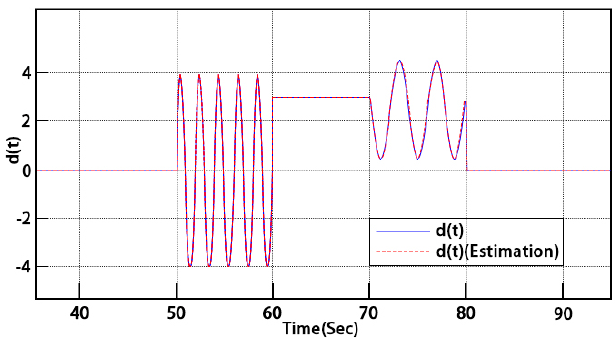
Figure 3. Wind speed.